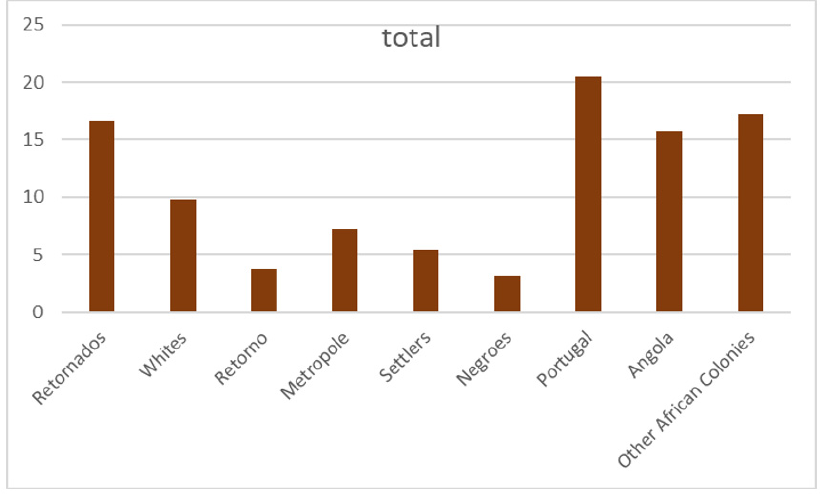
Figure 18. Most frequent words in the corpus selected for analysis.